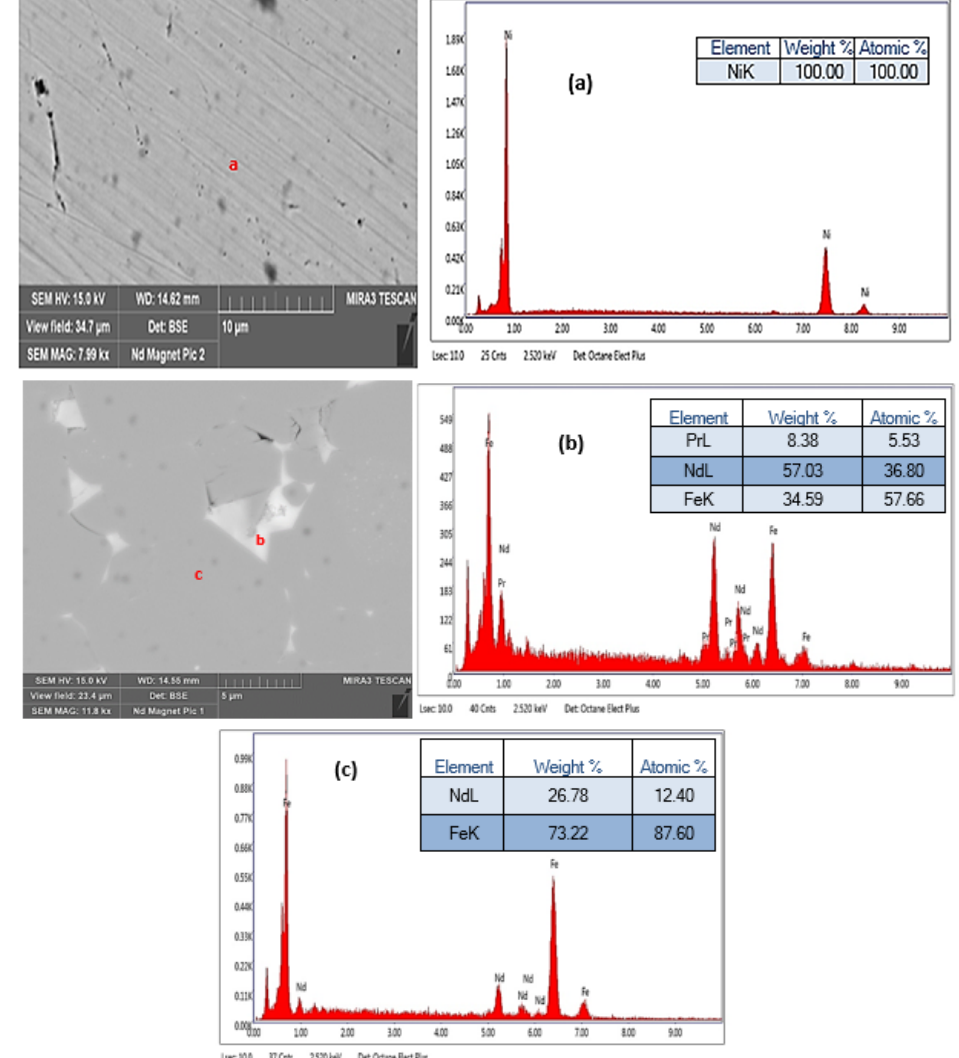
Figure 3. SEM image and EDX composition of the demagnetized and comminuted sample (see text for details). ( a ) Ni; ( b ) Pr, Nd, Fe; ( c ) Nd, Fe.